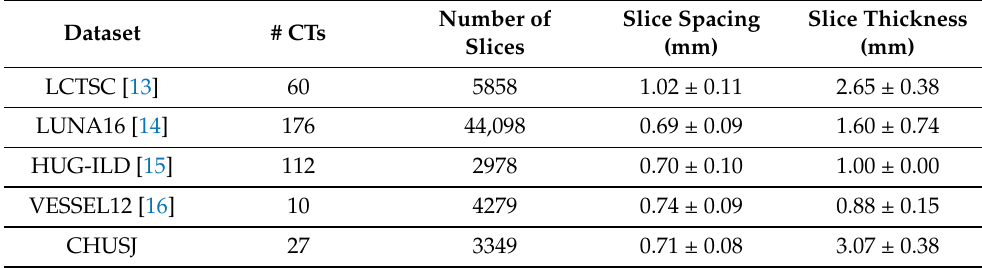
Table 1. Datasets descriptions regarding final number of CT scans, number of slices, slice spacing, and slice thickness.